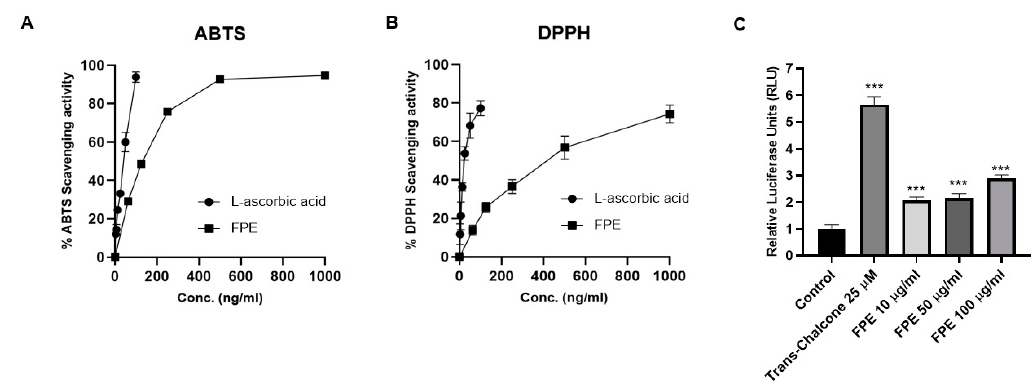
Figure 4. Antioxidant activity of FPE measured by biochemical assays. ( A ) 2,2-Azino-bis3- ethylbenthiazoline-6-sulfonic acid (ABTS) radical scavenging ability of the 95% ethanol fraction of flos puerariae. ABTS assay showed a dose-dependent enhancement in the antioxidant activity of FPE. Quantitation of the results from three independent experiments ( n = 3) is shown as mean ± SD with statistical significance as * p < 0.05, ** p < 0.01, and *** p < 0.001. ( B ) The DPPH radical scavenging activities of the 95% ethanol fraction of flos puerariae. The result showed a dose-dependent enhancement in the antioxidant activity of FPE. Quantitation of the results from three independent experiments ( n = 3) is shown as mean ± SD with statistical significance as * p < 0.05, ** p < 0.01, and *** p < 0.001. ( C ) Dose-dependent effect of FPE in inducing ARE-luciferase expression. HCT116 cells transiently transfected with ARE-luciferase plasmid vectors were treated with 10, 50, and 100 µ g / mL FPE. Cells treated with 50 µ g / mL trans-Chalcone were considered as a positive control. Dual-luciferase assay was performed 24 h after treatment of cells with plant extracts. Results are expressed as mean ± SEM; n = 3, *** p < 0.0001.